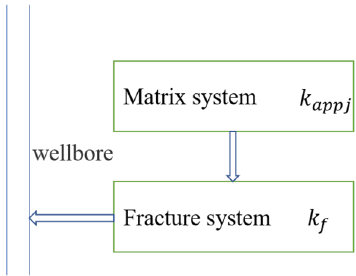
Fig. 1 Simplified migration mechanism